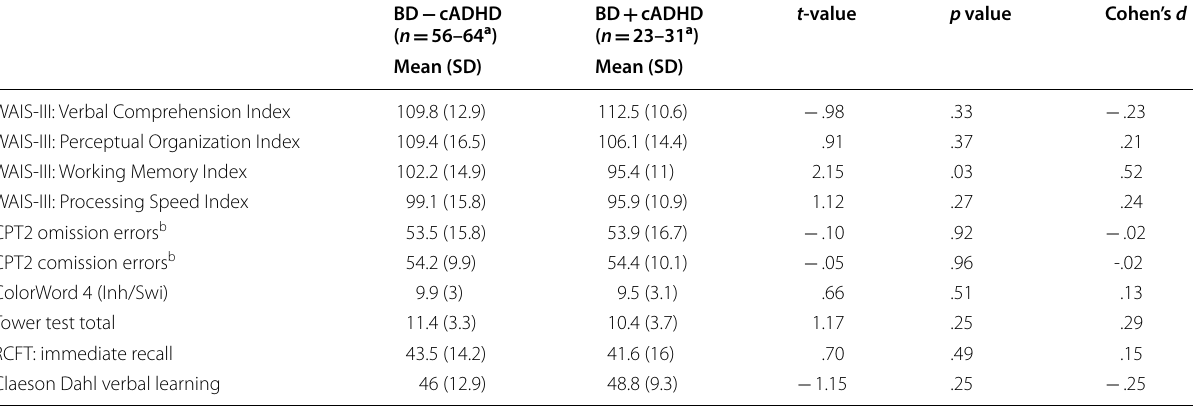
Table 2 Comparison of neuropsychological test performance of the bipolar disorder group without childhood ADHD (BD cADHD) and the bipolar disorder group with childhood ADHD (BD −